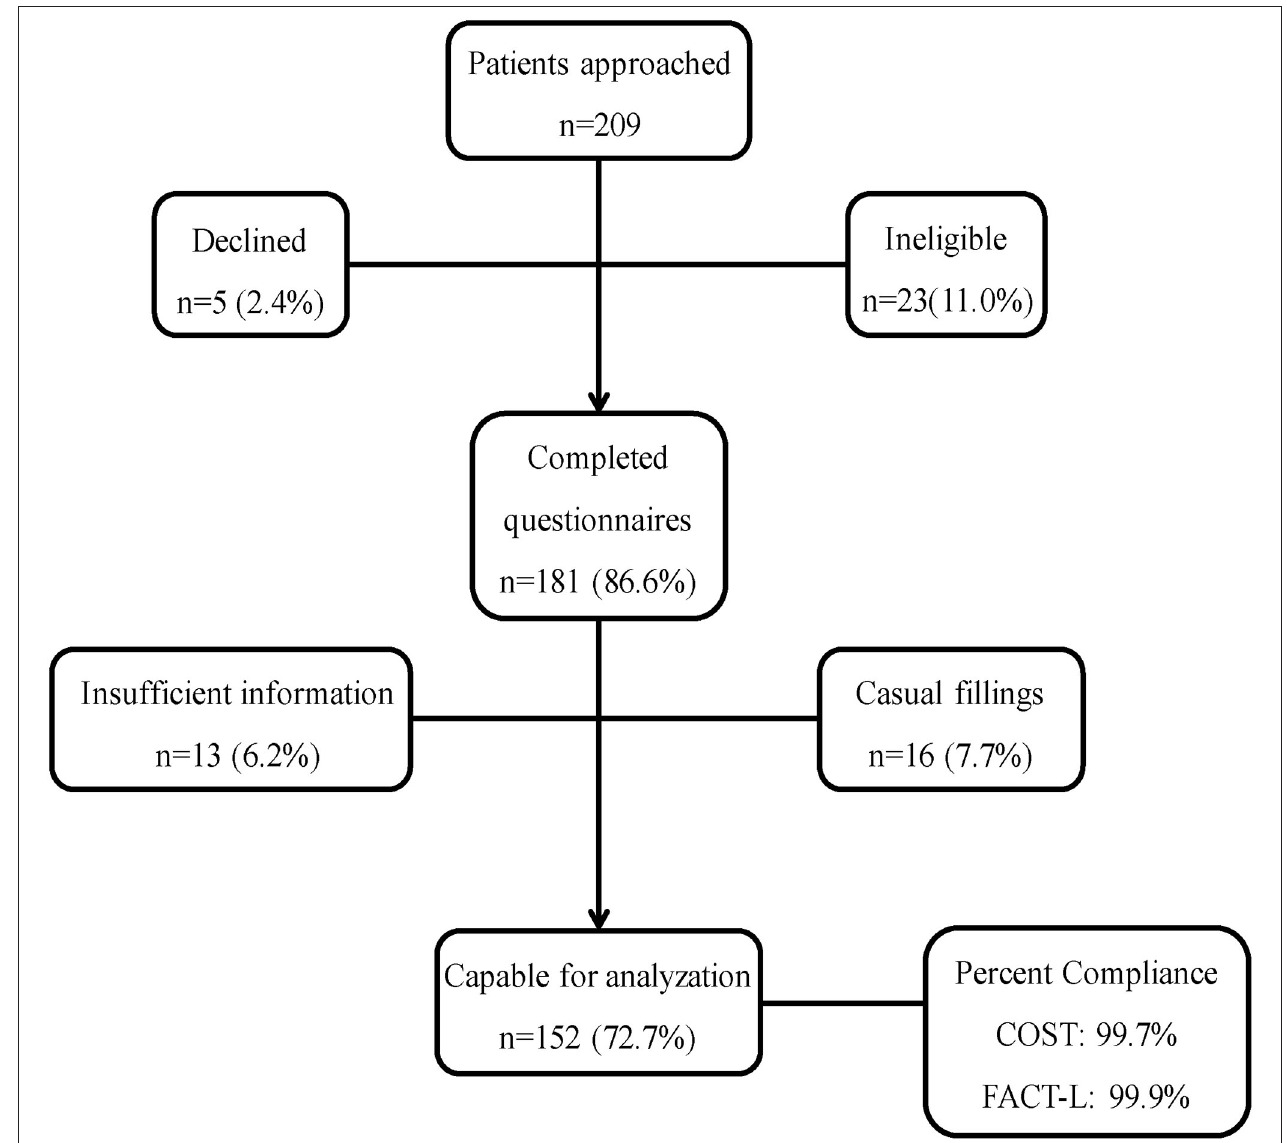
FIGURE 1 | Patient Recruitment Process. COST, the COmprehensive Score for Financial Toxicity; FACT-L, the Functional Assessment of Cancer Therapy-Lung